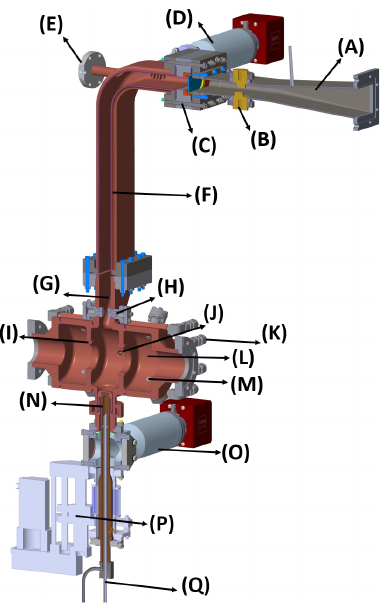
FIG. 2. A 2.1 GHz cavity cross section view. (a) Waveguide adaptor from JLab530 to WR430; (b) bolt with a nonconcentric knob; (c) JLab C100 rf window; (d) vacuum pump near the rf window; (e) view port; (f) FPC waveguide; (g) FPC port; (h) FPC tuner; (i) nose cone; (j) pickup coupler; (k) cavity water cooling channel; (l) cavity body; (m) fixed tuner; (n) main